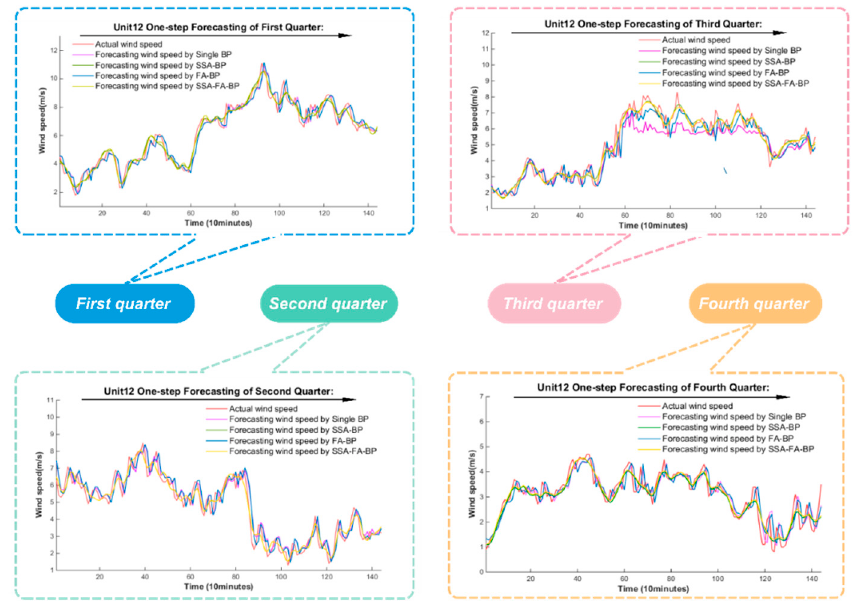
Figure 7. The multiple ‐ steps forecasting accuracy indexes of Unit 12 (10 min). Table 4. The quarterly forecasting results of the combined model and the results of the other models involving the data of three Units (10 min).